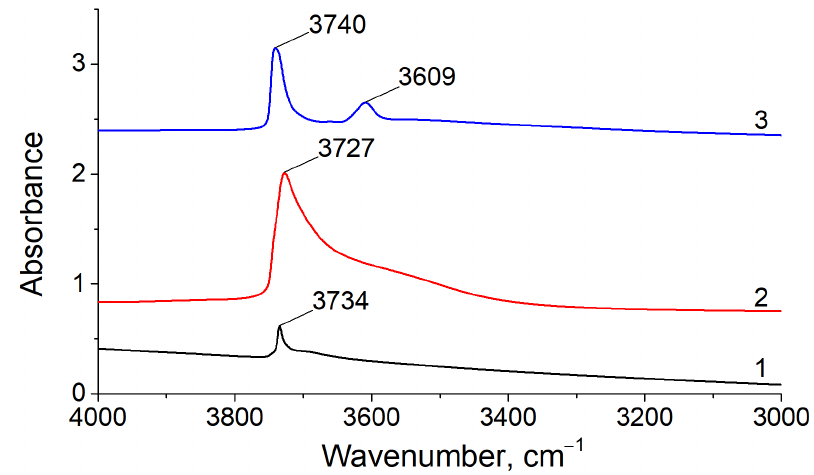
Figure 3. FTIR spectra of Sn-BEA (1), DeAl-BEA (2), and BEA (3) before Py adsorption; spectra are offset for clarity.